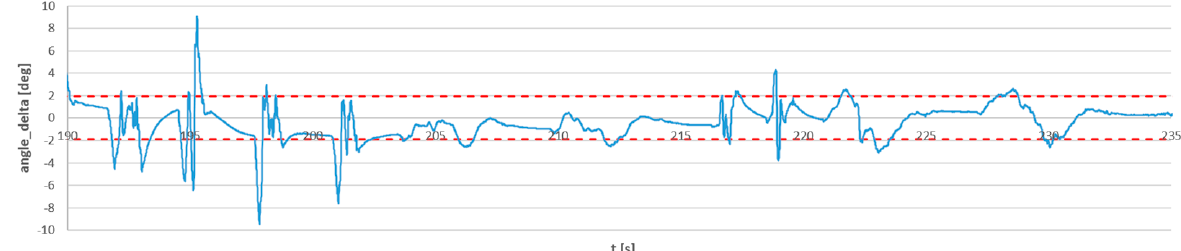
Figure 17. The angle deviation between the FC sensor and the reference MTi G-700 sensor. The red lines represent the standard deviation of the FC signal according to the reference MTi signal.